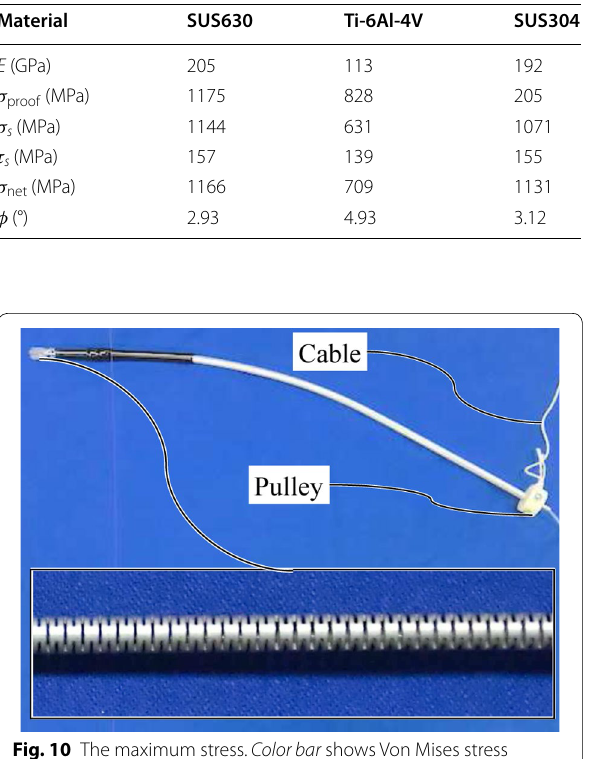
Fig. 10 The maximum stress. Color bar shows Von Mises stress